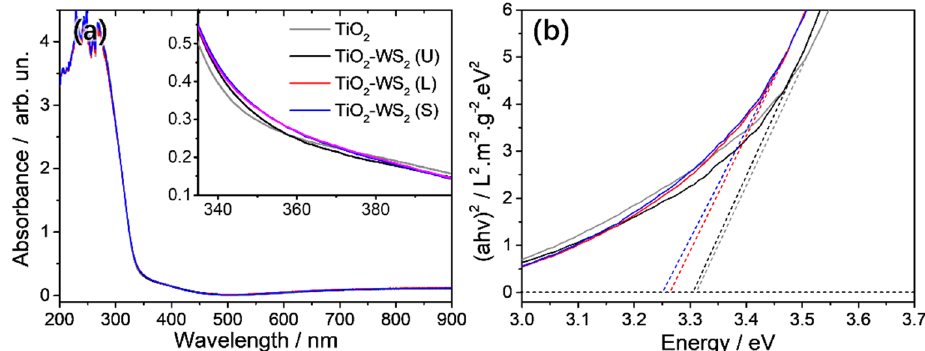
Figure 5. ( a ) XRD patterns and ( b ) Raman spectra of WS 2 -TiO 2 films: undoped TiO 2 (grey line), TiO 2 - WS 2 -U (black line), TiO 2 -WS 2 -L (red line), and TiO 2 -WS 2 -S (blue line). The signal at 521.5 cm − 1 , marked with an asterisk, is caused by the monocrystalline Si wafer. Figure 6. ( a ) UV-Vis absorption spectra and ( b ) Tauc plots of WS 2 -TiO 2 films: undoped TiO 2 (grey line), TiO 2 -WS 2 -U (black line), TiO 2 -WS 2 -L (red line), and TiO 2 -WS 2 -S (blue line). The inset in ( a ) shows an enlarged region in the 330–400 nm region.